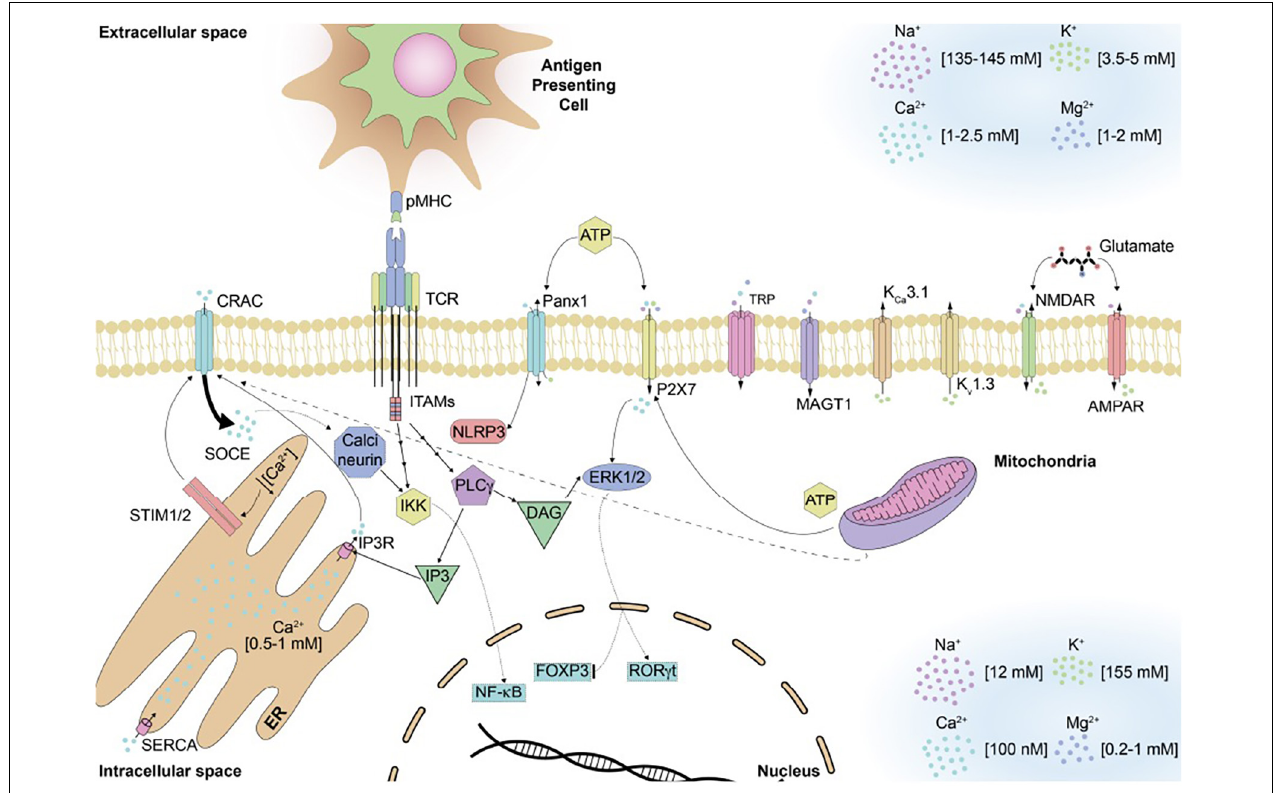
FIGURE 2 | Ion channels and signaling pathways described for T cells. Several channels responsible of regulating the ion homeostasis can be found on the surface of T cells. These channels maintain the different concentrations of ion in the extracellular and intracellular space and are permeable to specific ions. T cell receptor engagement with the pMHC molecule found on antigen presenting cells will induce a signaling cascade that will result on the influx of Ca 2 + and eventual store-operated Ca 2 + entry inside of T cells. All these events will result in the activation of different transcription factor that will activate the effector function of T